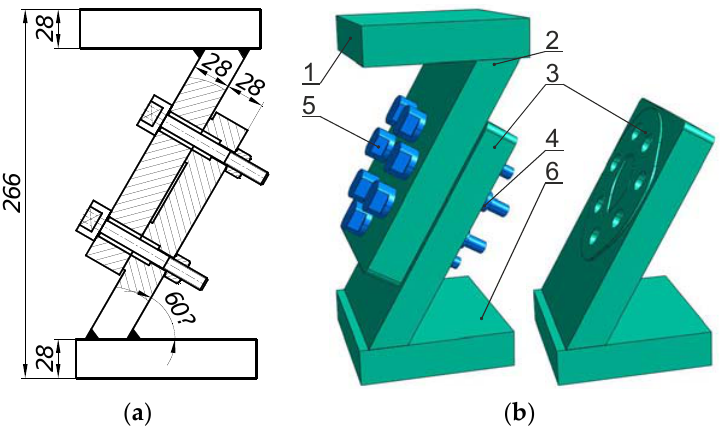
Figure 1. Tested connection: ( a ) diagram; ( b ) 3D view (1—upper plate; 2, 3—joined plates; 4—high hexagonal nut; 5—M10x1.25 bolt; 6—base).